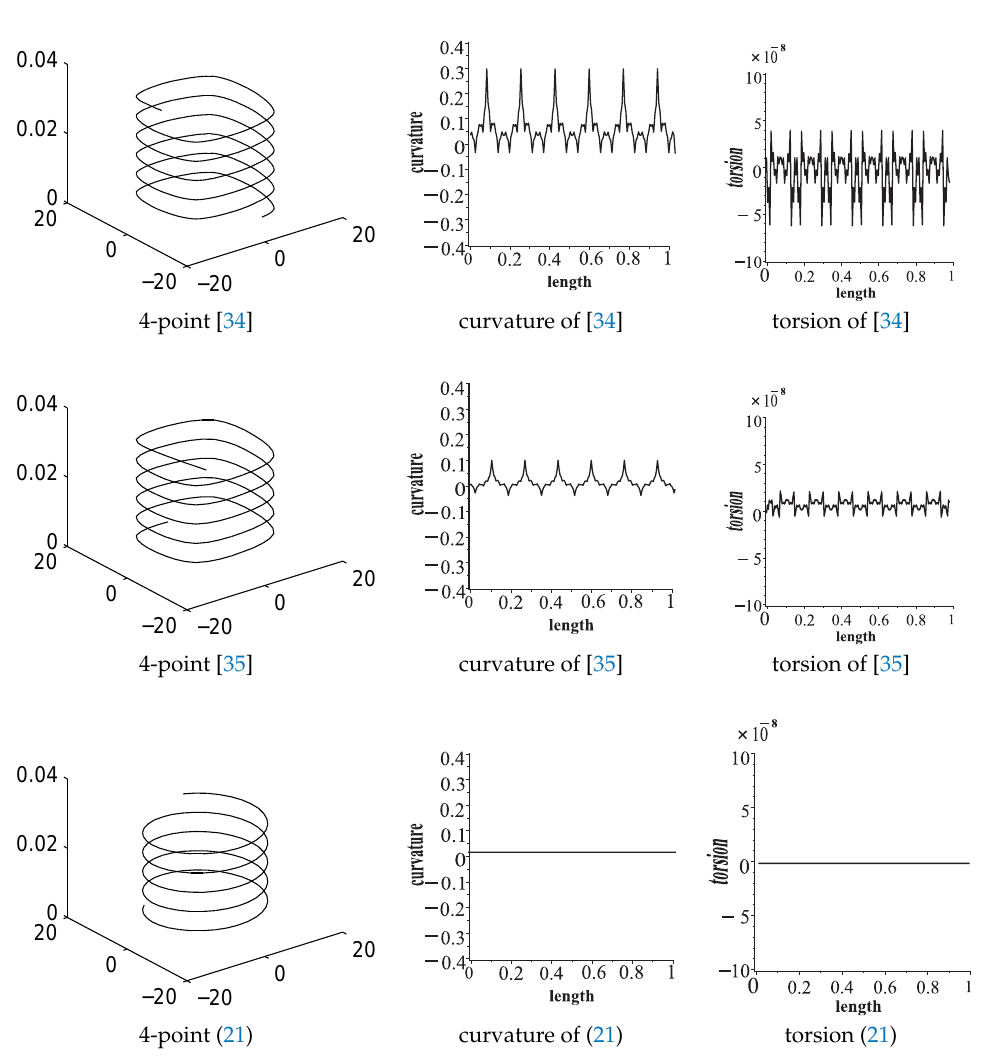
Figure 5. Results of 5th iteration of the 4-point and 5-point schemes of [34,35] and (21) are shown on the left when the initial control points are sampled from Helix. The corresponding curvatures and torsions are shown in the center and right column,